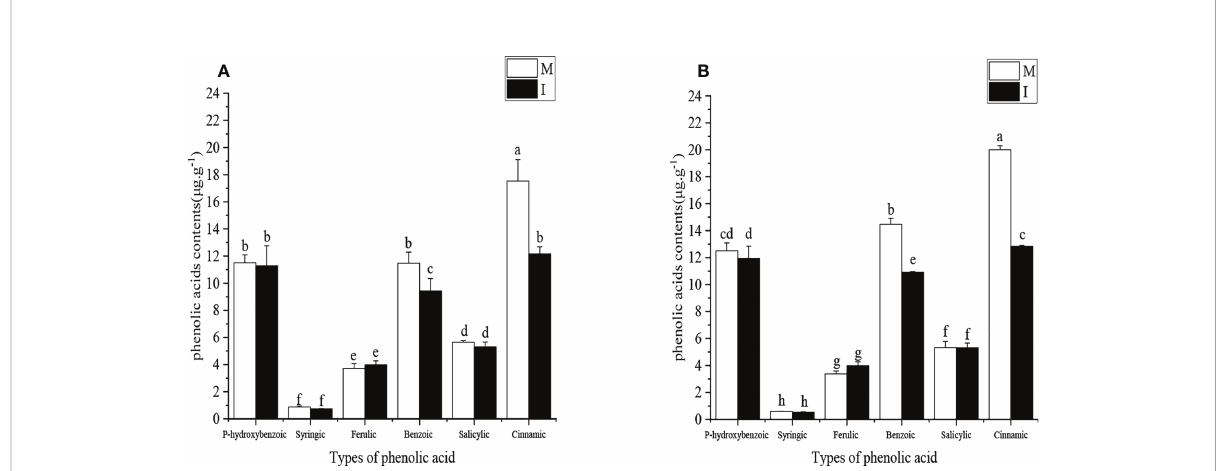
Compared with monoculture, intercropping with F, F+50B, F+100B, and F+200B signi fi cantly reduced the incidence of Fusarium wilt by 42%, 13%, 19%, and 23%, respectively (Table 1). Under the F, F+50B, F+100B, and F+200B treatments, intercropping signi fi cantly reduced the disease index of Fusarium wilt by 32%, 53%, 25%, and 22%, respectively (Table 1). Under the monoculture cultivation mode compared with F, F+50C, F+100C, and F+200C signi fi cantly increased the incidence of Fusarium wilt by 44%, 111%, and 178%, respectively (Table 2). In the monocropping mode, compared with F, F+50C, F+100C, and F+200C signi fi cantly increased the disease index of Fusarium wilt by 28%, 91%, and 159%, respectively (Table 2). Compared with monocropping, intercropping with F, F +50C, F+100C, and F+200C signi fi cantly reduced the incidence of Fusarium wilt by 42%, 31%, 26%, and 20%, respectively (Table 2). Compared with monocropping, F, F